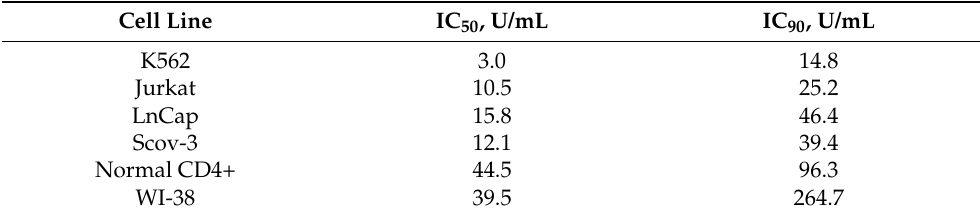
Table 2. IC 50 and IC 90 values of MrAII for cancer and normal cell